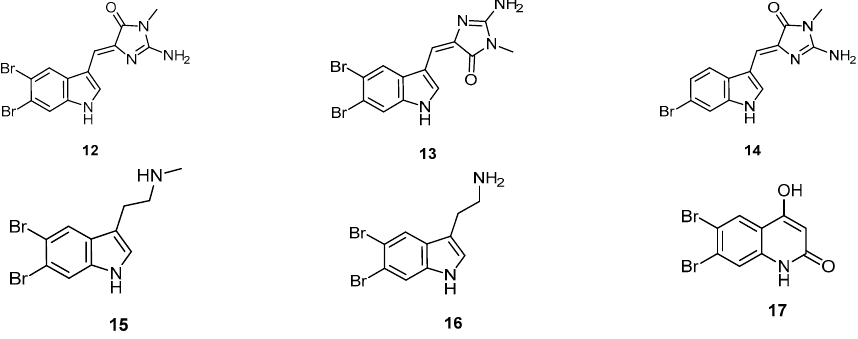
Figure 5. Chemical structures of the indole alkaloids ( 12 – 16 ) and compound 17 .